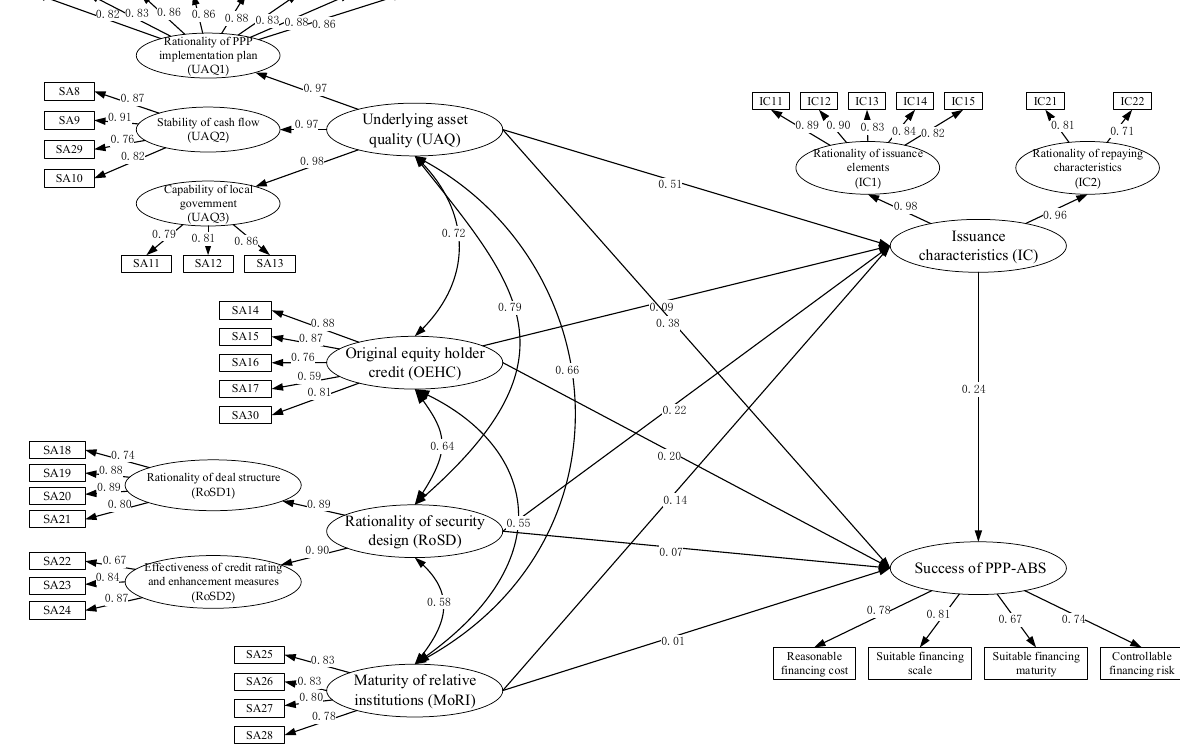
Figure 2. Final SEM model (relative contribution of CSFs on the constructs alongside path coefficients).